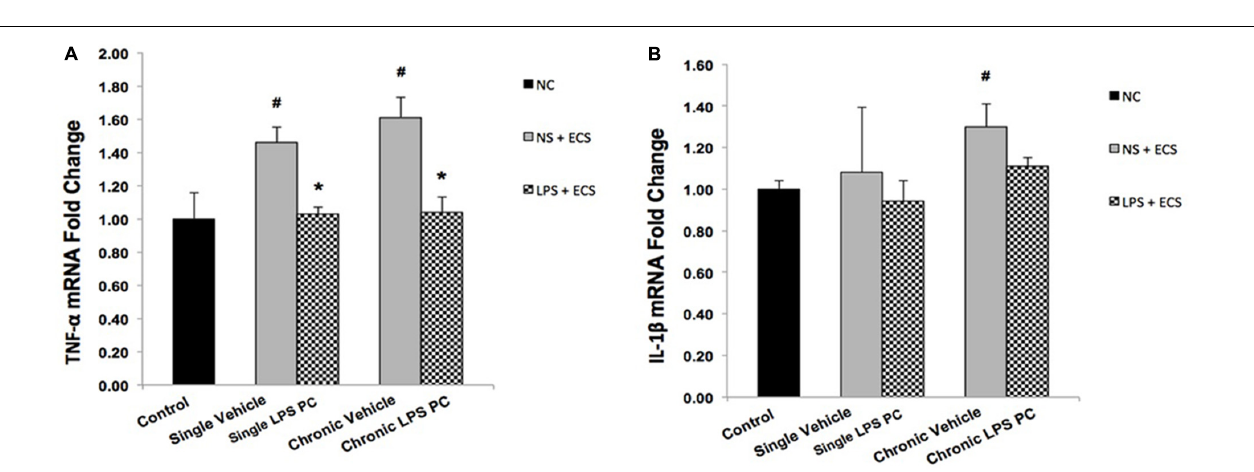
FIGURE 9 | Gene expression level of TNF- α and IL-1 β in the hippocampus region of rat brain in the ECS model of epilepsy. The graphs above display the effect of preconditioning by single low dose and chronic ultra-low dose of LPS on the gene expression level of (A) TNF- α and (B) IL-1 β in hippocampus in control, single preconditioned, and chronic preconditioned groups. Asterisk ( ∗ ) denotes a significant difference between the preconditioned groups and vehicle groups. Hash (#) denotes a significant difference between the vehicle groups and control groups. Statistical analysis was done according to the one-way ANOVA with significance levels of ∗ ρ < 0.05 and # ρ < 0.05. Data are shown as mean ± SEM of three animals ( n = 3), which expressed as fold change relative to control group. ECS, electroconvulsive shock; NS, normal saline; LPS, lipopolysaccharide; PC, preconditioning; NC, no current was passed through the electrodes.